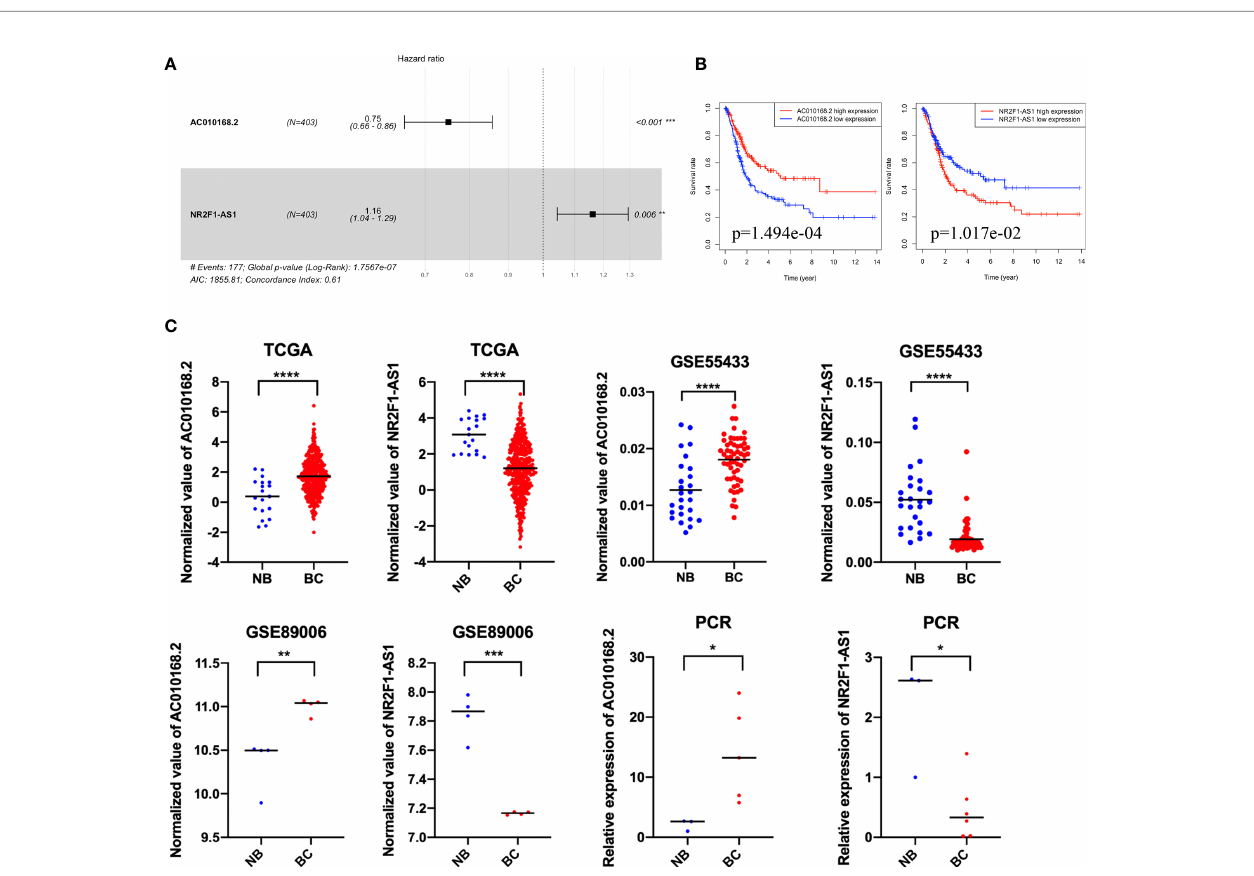
FIGURE 3 | The expression pattern and prognosticvalue of AC010168.2 and NR2F1-AS1. (A) Forest plot of AC010168.2 and NR2F1-AS1 was involvedin the ceRNA network. (B) Kaplan-Meier curve of AC010168.2 andNR2F1-AS1. (C) The expression of AC010168.2 and NR2F1-AS1 in bladder cancer tissue and adjacent normaltissue. Validation of cohorts (GSE89006 andGSE55433). These results were also validated byreal-time PCR. *p <0.05, **p <0.01, ***p < 0.001, ****p